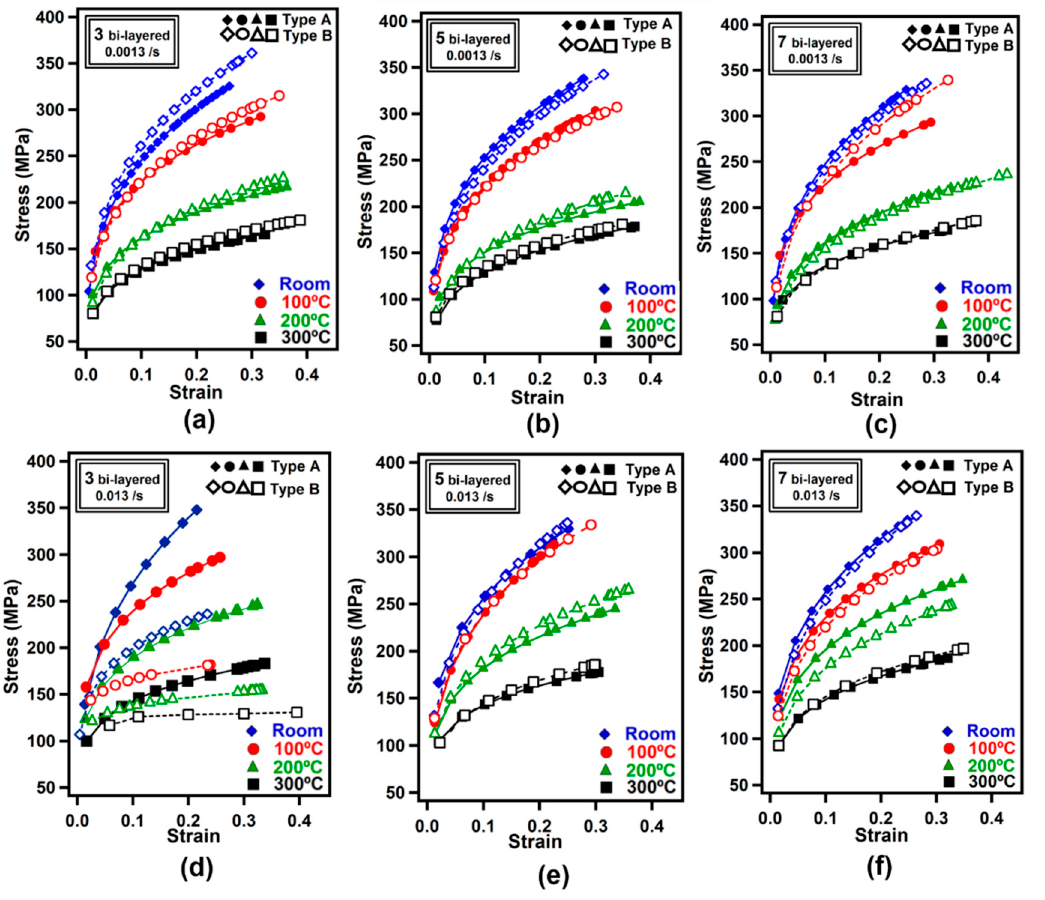
Figure 5. Stress-strain curves obtained for laminated metal composites obtained from tensile tests; ( a – c ) at a strain rate of 0.0013/s, and ( d – f ) at a strain rate of 0.013/s.